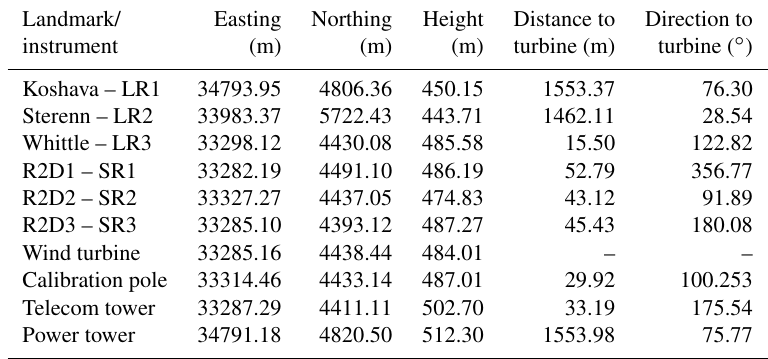
Table 3. Position of instruments and landmarks given in datum ETR89/PTM06 (m). Landmark/ Easting Northing Height Distance to Direction to instrument (m) (m) (m) turbine (m) turbine ( ◦